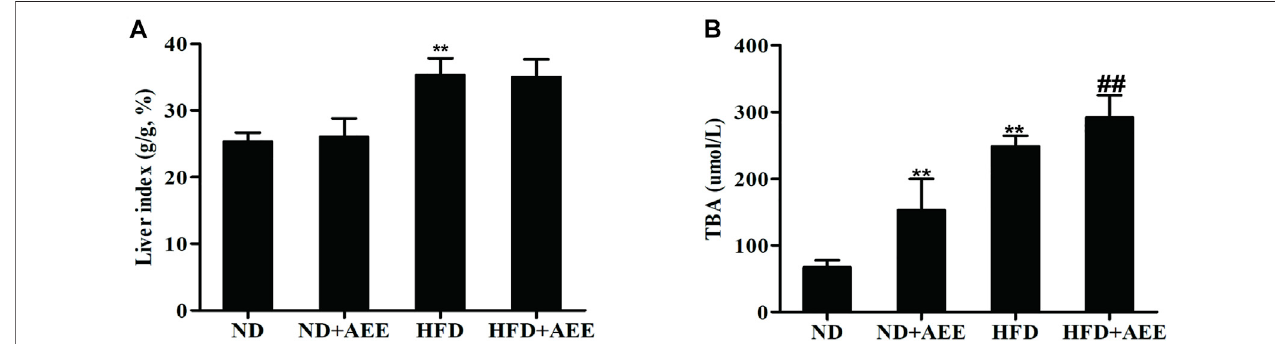
FIGURE 4 | Effect of AEE on liver index and fecal TBA in hyperlipidemia rat. (A,B) Effect of AEE on liver index and fecal TBA in hyperlipidemia rat. (A) AEE reduced liver index in hyperlipidemia rat. Liver index: the ratio of liver weight to body weight (%). (B) The effect of AEE on TBA in feces of rats. Data are expressed as the means ± SD ( n (cid:1) 10). ND: Normal diet; HFD: high-fat diet; AEE: aspirin eugenol ester, ** p < 0.01 compared with the ND group; ## p < 0.01 compared with the HFD